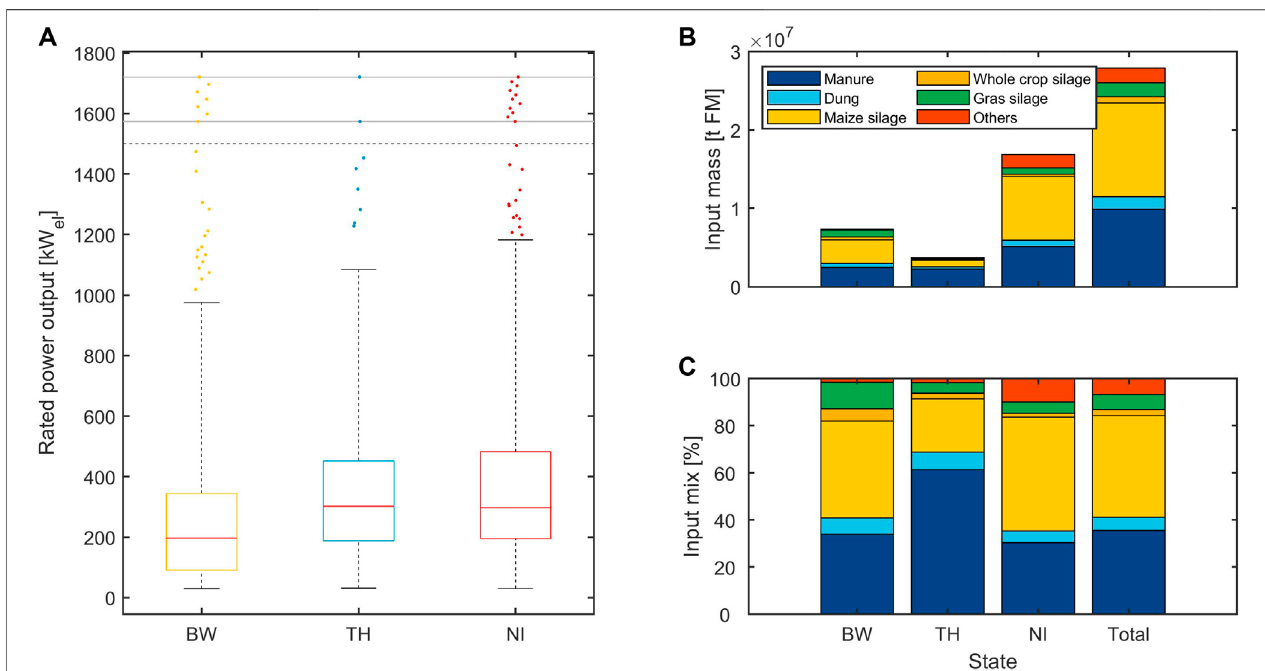
FIGURE 2| Regional distribution of rated power output (A) and average substrate mix in the states of BW, TH, and NI in absolute (B) and relative (C) terms (based on Härdtlein et al. (2013), Reinhold (2015), TLL (2015), Reinhold (2017), Matschoss et al. (2019)); BW, Baden-Wuerttemberg; TH, Thuringia; NI, Lower Saxony.